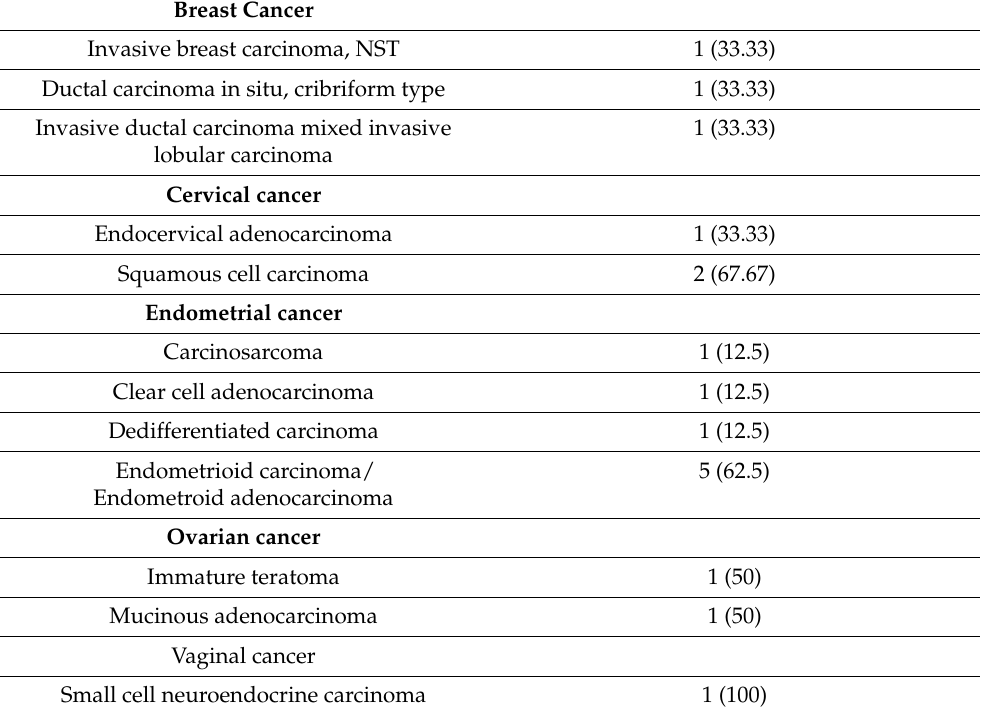
Table 4. Histological types of the study population.